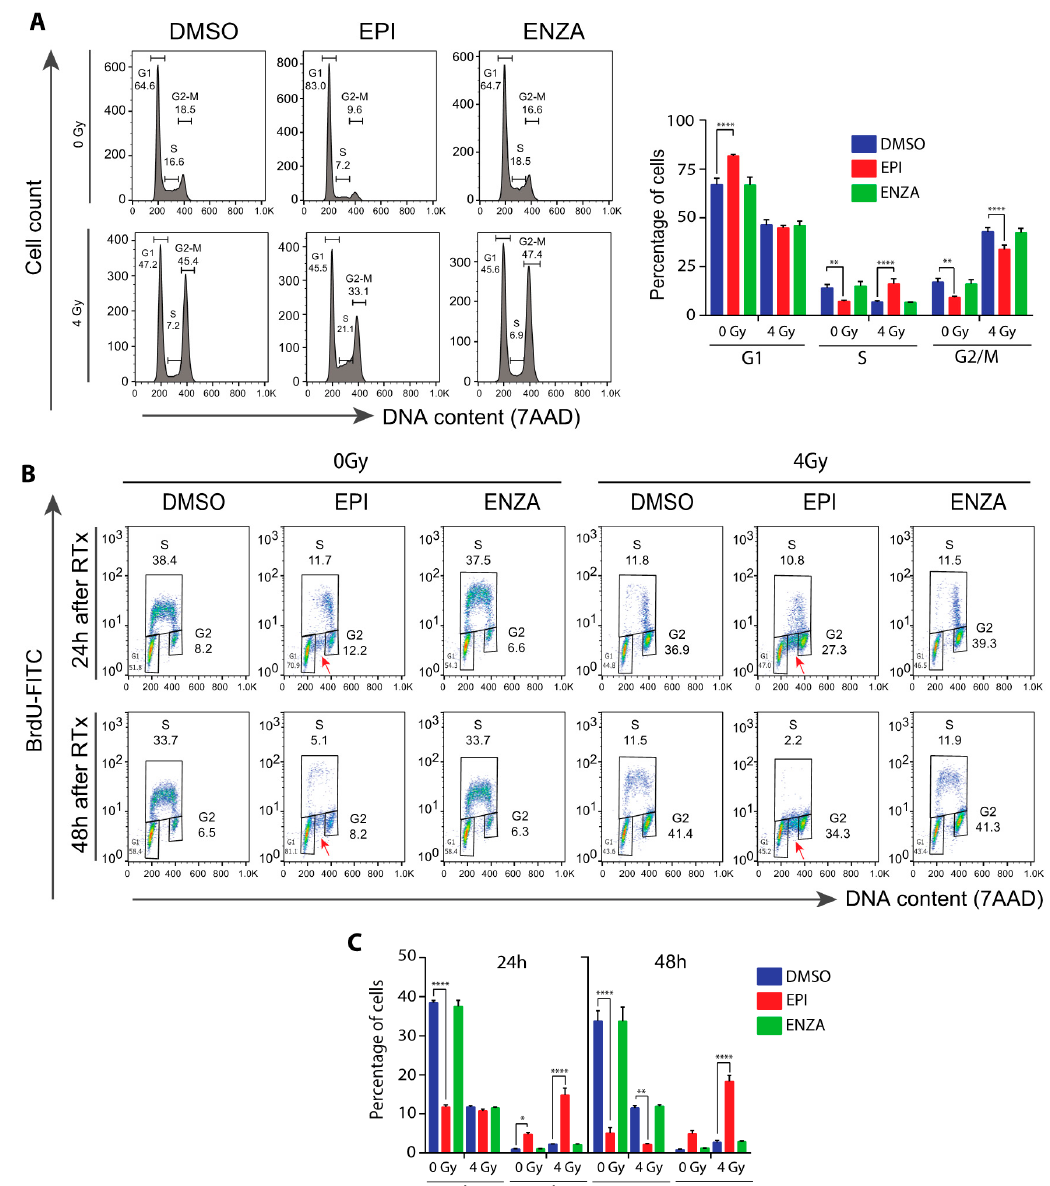
Figure 5. Combination therapy of IR plus ralaniten maximizes blockade of DNA synthesis and increases accumulation of cells stalled in S phase of the cell cycle. EPI alone caused G1 arrest. IR alone caused G2 / M arrest. EPI plus IR caused greater S arrest so that cells were not able to continue to G2 / M and then G1. LNCaP95 cells were pretreated for 2 h with DMSO, ralaniten (EPI; 35 µ M), ENZA (5 µ M) prior to IR and then incubated an additional 24 or 48 h. After labelling for 2 h with 10 µ M BrdU, the cells were stained with BrdU-FITC antibody and 7-AAD, and subjected to FACS analysis. ( A ) Representative histograms of 7-AAD stained cells 48 h after IR are shown (left panel) and the average percentages of cells in each phase of the cell cycle (right panel). ( B ) Representative bivariate plots of BrdU and 7-AAD for cells exposed to monotherapy or combinations for 24 or 48 h, as indicated above. The fraction of cells in G1, S, and G2 phases are indicated next to the corresponding box. The red arrows designate cells in S phase that did not incorporate BrdU. ( C ) Quantification of BrdU-positive (gated as S) and BrdU-negative (indicated by red arrows) cells from bivariate plots after 24 or 48 h of treatments. For A and C, the bars represent the means ± SEM from n = 3 independent experiments. * p < 0.05, ** p < 0.01, **** p < 0.0001; ANOVA with Tukey’s multiple comparisons test was used.